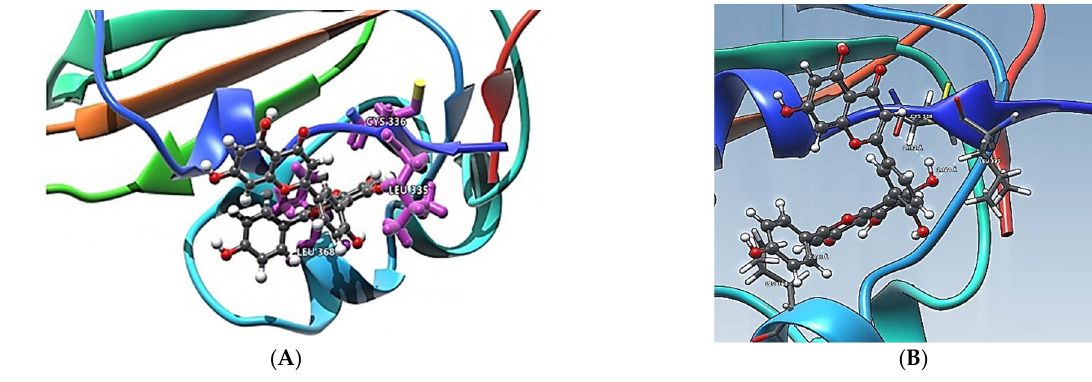
Figure 4. ( A ) Amentoflavone complexes with RDB. Docking pose for Amentoflavone showing some closed localized amino acids (LEU 335, 368 and CYS 336) of its environment; ( B ) Hydrogen-acceptor and hydrogen-donor distances for Amentoflavone with LEU 335, 368 and CYS 336.